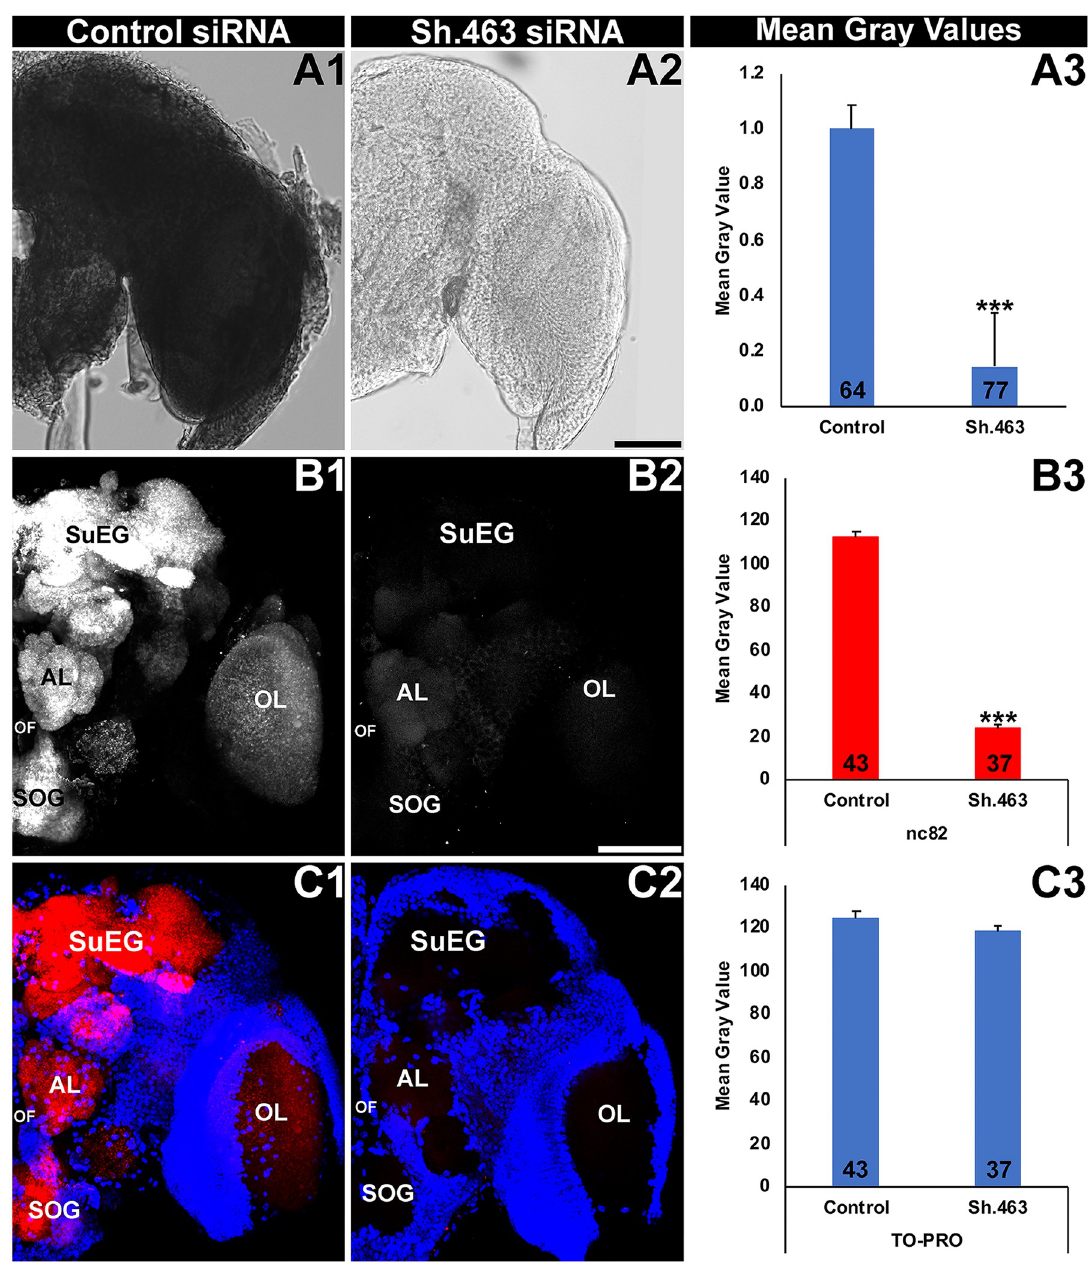
Fig 2. siRNA-mediated silencing of Aae Sh results in neural defects in A . aegypti adults. The high levels of Aae Sh expression detected throughout the A . aegypti adult female brain (a control siRNA-treated brain is shown in A1) were significantly reduced in adults injected with Sh.463 siRNA (A2). Adult brains were labeled with mAbnc82 (white in B1, B2; red in C1, C2), which labels synaptic active zones, and the nuclear stain TO-PRO (blue in C1, C2). nc82 levels were significantly reduced (B3) in the synaptic neuropil of adult females injected with Sh.463 siRNA (B2, C2; compare to white staining of control siRNA-injected brain in B1/red staining in C1). In A3, B3, and C3, data are represented as average mean gray values, and error bars denote SEM; ��� = P < 0.001 when compared with control siRNA-injected mosquitoes. Representative adult brains are oriented dorsal upward in this figure. AL: antennal lobe; OL: optic lobe; SOG: sub-esophageal ganglion; SuEG: supra-esophageal ganglion. Scale Bar = 100 μ m.